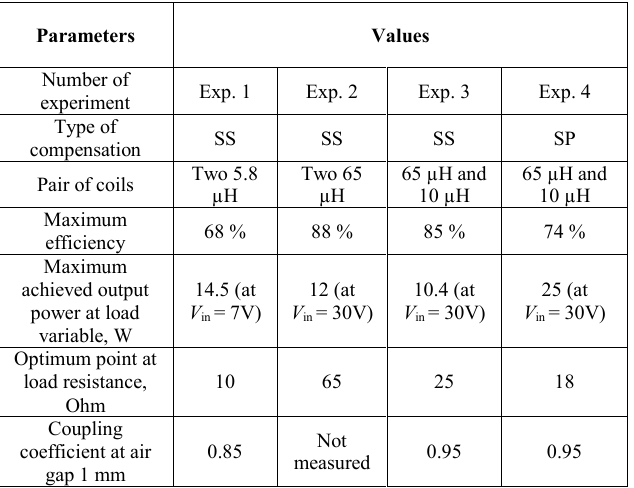
inductors. Table II summarises the main points of study of different coils at different compensation